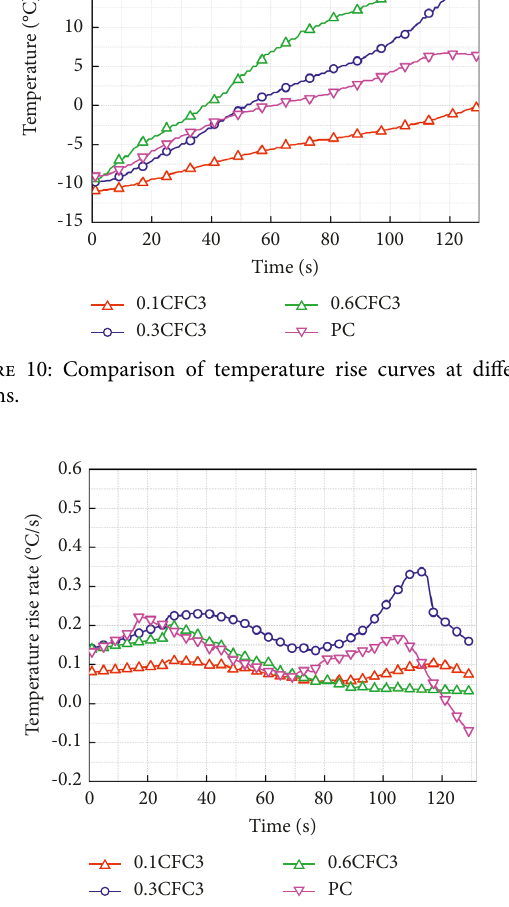
Figure 11: Comparison of temperature rise rate curves at different lengths.